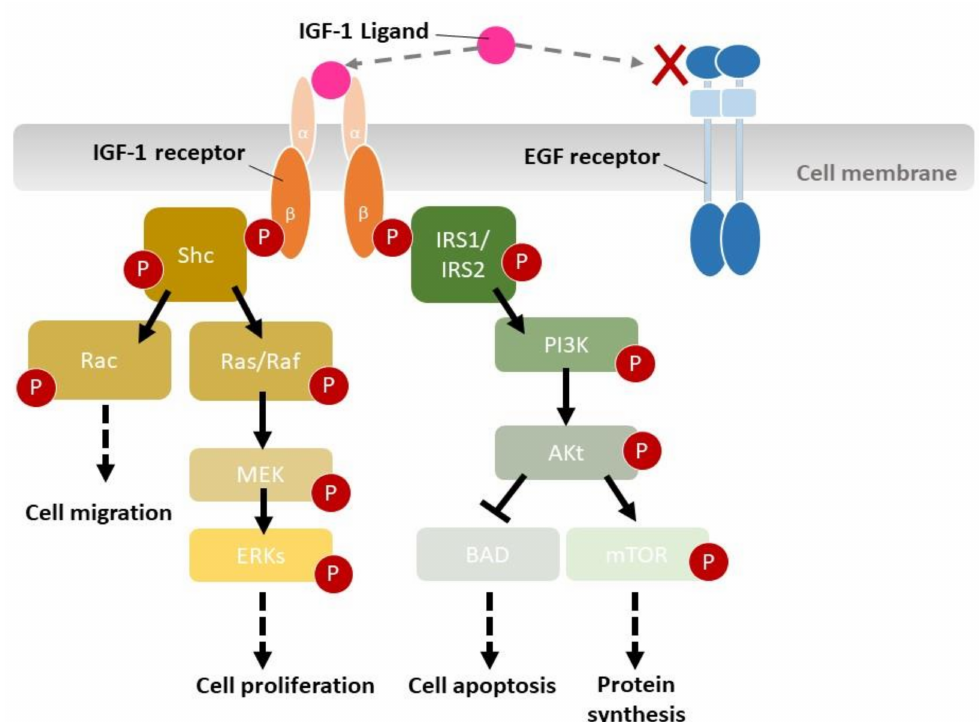
Figure 8. Schematic representation of insulin-like growth factor 1 (IGF-1) triggering the insulin-like growth factor type 1 receptor (IGF1R)-related signal transduction pathway. Activation of the IGF-1 receptor (IGF1R) triggers several signaling pathways. IGF1R, a tyrosine kinase, auto-phosphorylates multiple cellular proteins, including members of the Shc, Rac, Ras/Raf, and IRS1/IRS2 families. Considering phosphorylation, Shc was activated to regulate Rac and Ras/Raf. The Rac pathway is important for cell migration, while the Ras/Raf pathway is critical for proliferative responses. IRSs interact with signaling molecules, while activation of the PI3K and Akt pathways prevents apoptosis, also triggering protein